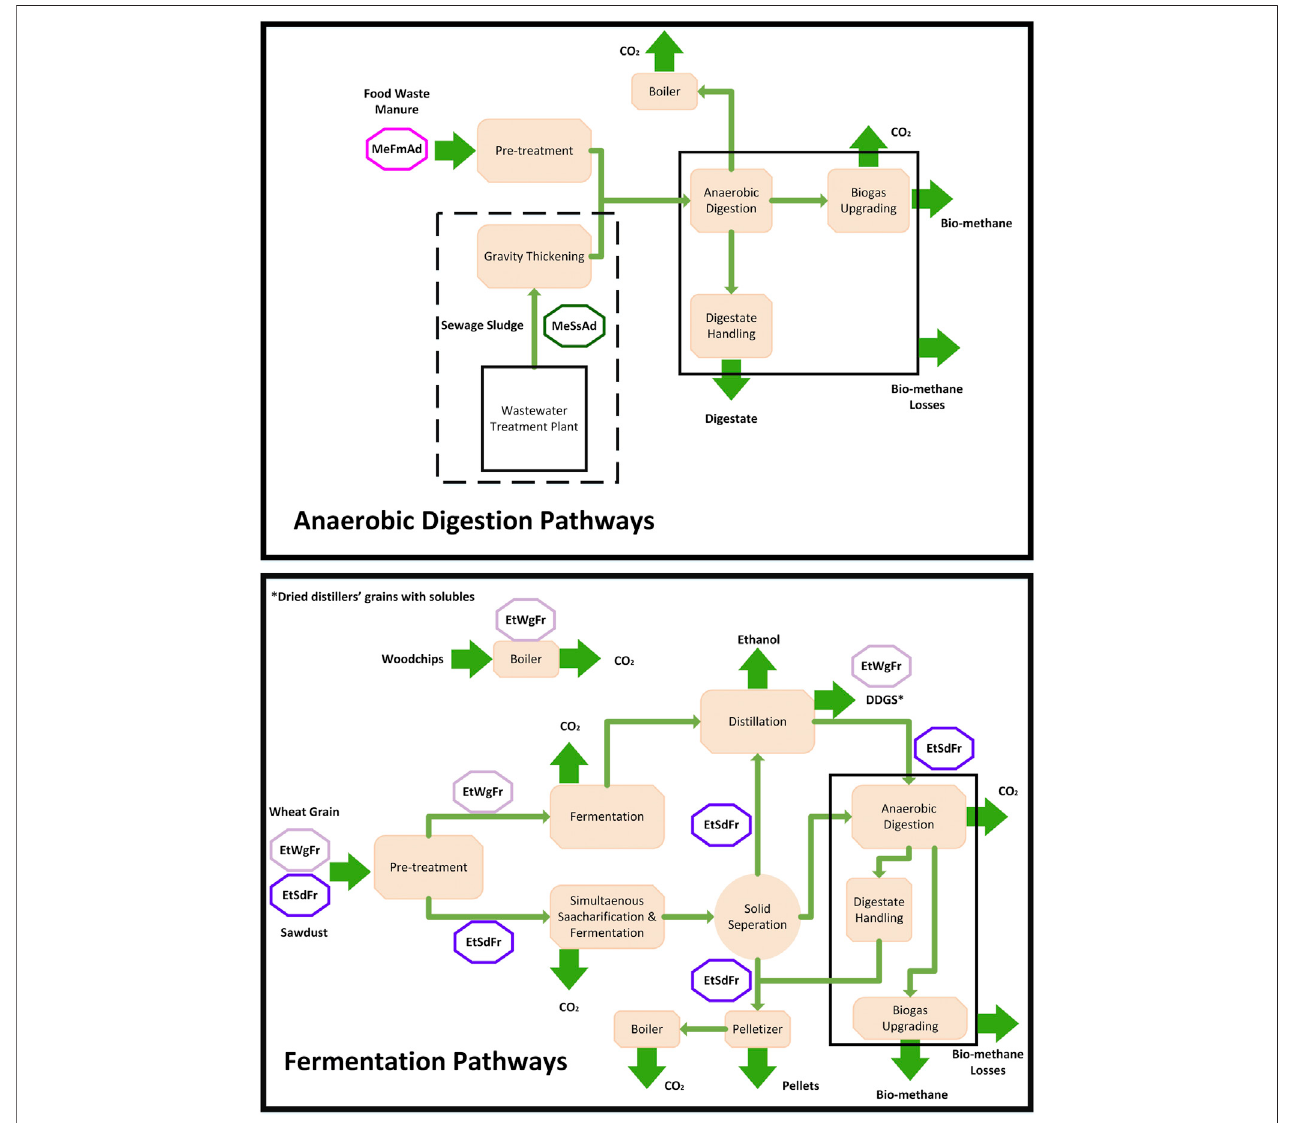
FIGURE 2 | Simpli fi ed schematic overviews of the fermentation and anaerobic digestion pathways. Abbreviations are used to separate process steps and inputs/ outputs that are speci fi c to a pathway from those that are common to two or more pathways. Only biogenic carbon fl ows are shown. Dashed lines indicate physical boundaries. For detailed process con fi gurations, see the Supplementary